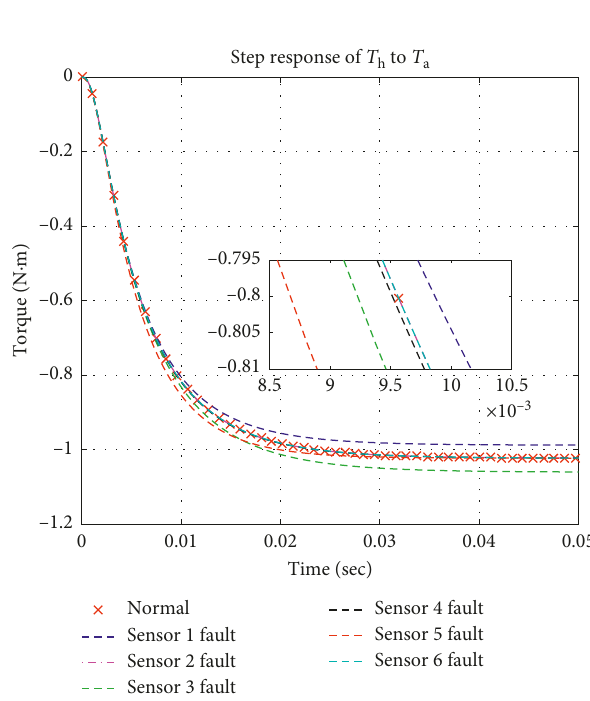
Figure 4: The step response of EPS system with a sensor failure.